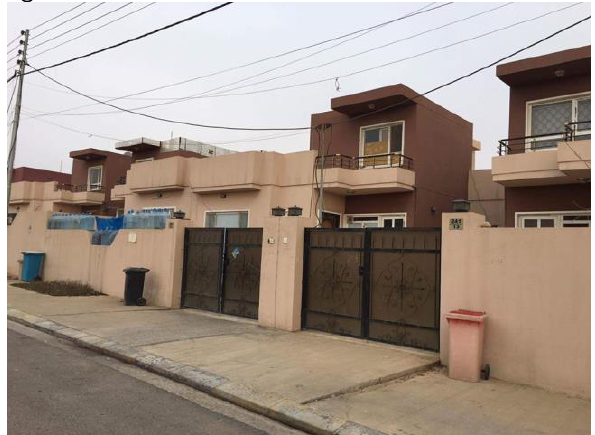
Figure 5. Goollun City housing project. (By Author).